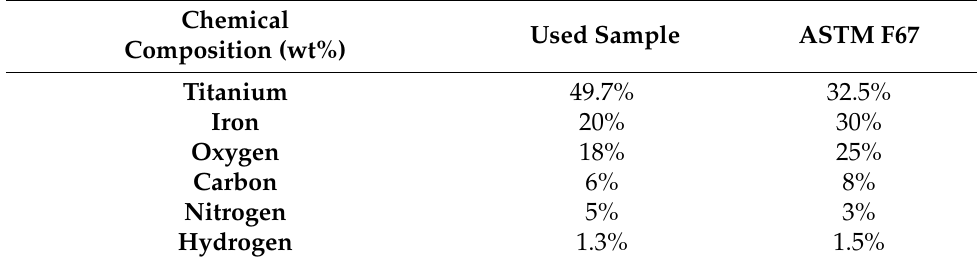
Table 1. Comparison of ASTM standard and chemical composition of Grade 2 α